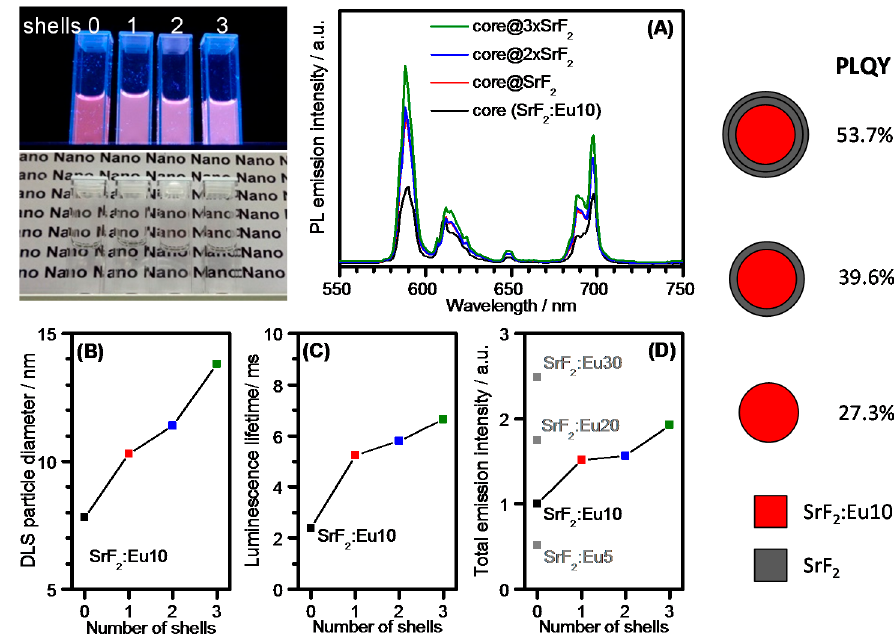
Figure 17. Core–shell particles SrF 2 :Eu10@ n × SrF 2 ( n = 0–3). Upper left: Pictures at daylight and under UV excitation (366 nm). ( A) PL emission spectra (ex. 393 nm); ( B ) DLS particle diameter (number); ( C ) Eu 3+ luminescence lifetime (em. 590 nm); ( D ) luminescence intensity (ex. 393 m), particles with different amounts of Eu 3+ doping are given for comparison. PLQY: Photoluminescence quantum yield. Reproduced from Reference [59] with the permission of the Royal Chemical Society.